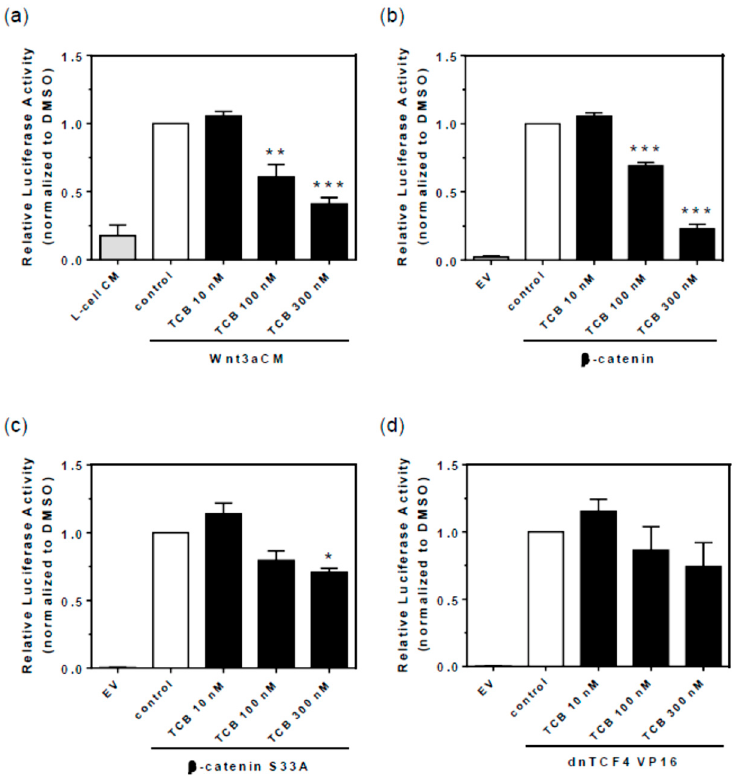
Figure 14. Wnt/ β -catenin signaling inhibition by TCB relies on β -catenin phosphorylation and degradation. Wnt/ β -catenin signaling pathway specific TOPFLASH gene reporter assay for LLC-PK1 cells treated with 10, 100, and 300 nM TCB with control L-cell (L-cell CM) or Wnt3a conditioned medium (Wnt3a CM) for inducing Wnt/ β -catenin pathway for 24 h ( a ). Cells were transfected with β -catenin, a constitutively active β -catenin mutant ( b ), β -catenin S33A ( c ), or constitutively active TCF4 construct dnTCF4 VP16 ( d ). Data are the mean ± SEM of at least three independent experiments. * p < 0.05; ** p < 0.01; *** p < 0.005 vs. control. EV, empty vector.